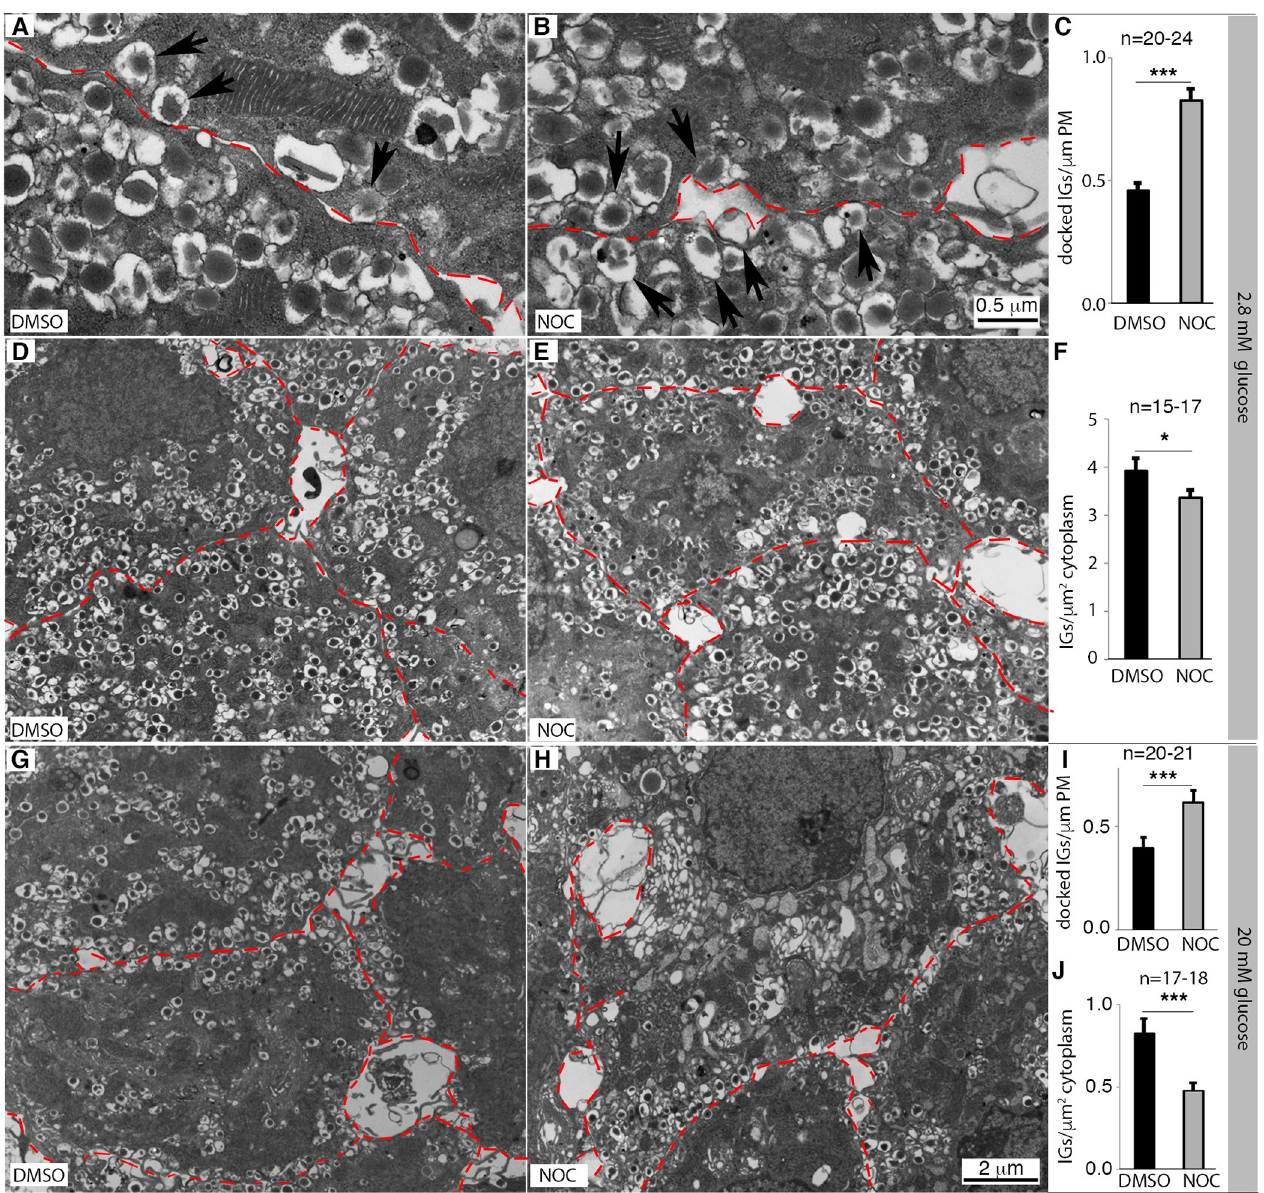
Fig 2. TEM assay of insulin SG in β cells in the absence of MTs. Islets were isolated from wild-type (WT) adult mice and were treated with DMSO or 10 μ g/ml NOC for ~12 hour at G2.8 or G20 mM. TEM was used to examine the locations and density of SGs in two batches of islets prepared on different days. (A-C) TEM images and quantification of SGs that localize near PM from DMSO- and NOC-treated islets in the presence of 2.8 mM glucose. (D-F). Images and quantification of SG density in microscopic fields used in (A-C). (G-J) Images and SG quantification as in (A-F), except 20 mM glucose was used. Scales in (D, E, G, H) are the same, labeled in panel (H). In (C), (F), (I), and (J), mean + SEM were presented ( � : p < 0.05, ��� : p < 0.001, from two-tailed type II t-test). In all panels, “n” indicates the number of microscopic fields counted (with 3–4 different β cells included in each field). In all images, red dashed lines mark recognizable β cell membrane. Please refer to S1 Table for original numbers used in